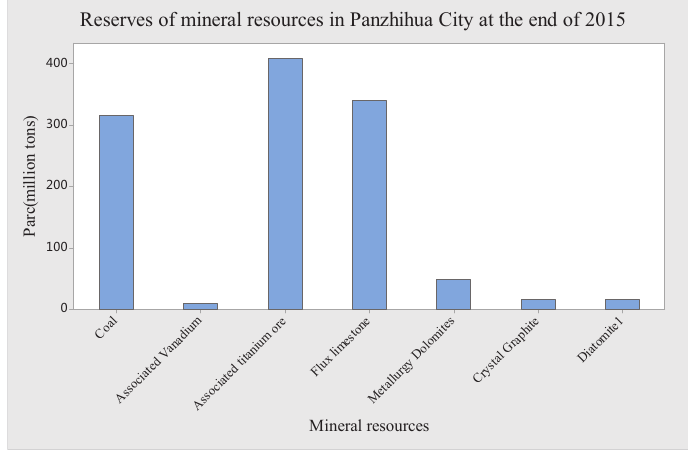
Fig. 1 Reserves of mineral resources in Panzhihua City at the end of